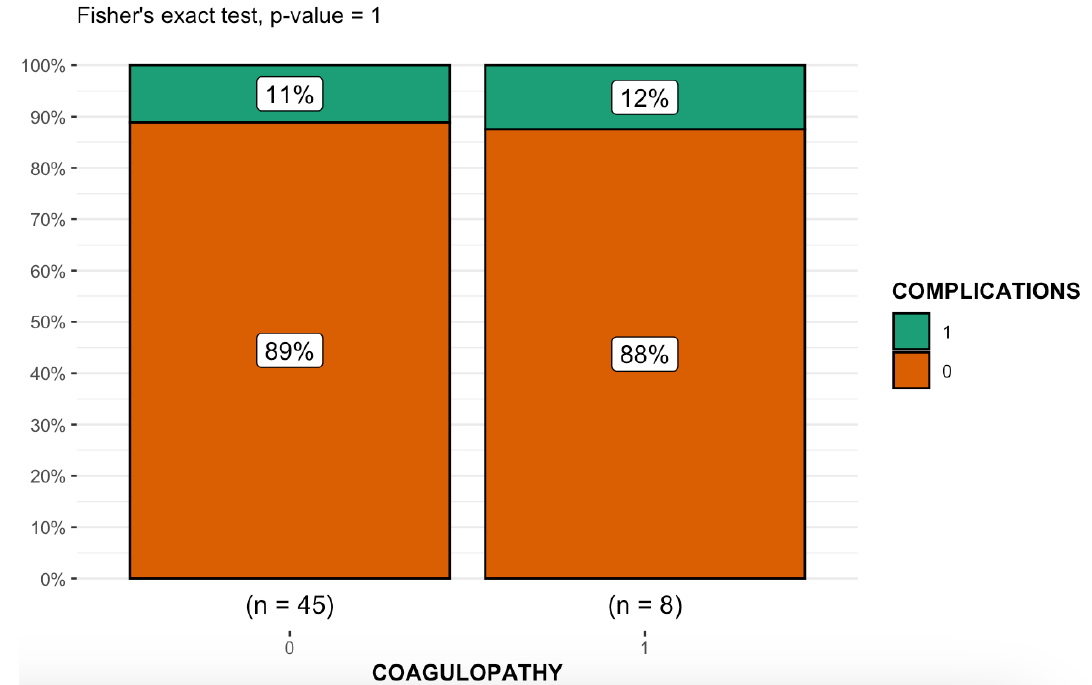
Figure 4. Boxplot representing the relationship between the two categorical variables, “Coagulopa- thy” and “Clinical Success”, analyzed using Fisher’s exact test.